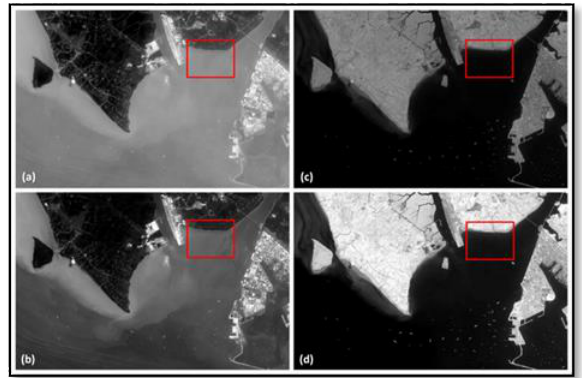
Figure 6. Landsat-8 multispectral satellite images of Tanjung Kupang, Strait of Johor area. Image (a) Blue (Band 2); (b) Green (Band 3); (c) Red (Band 4); and (d) NIR (Band 5). 3.3 Nautical Chart The measured bathymetric depths are obtained from the nautical chart MAL 5123 – Port of Tanjung Pelepas (scale 1 : 20,000). Image to map registration has been performed to precisely georeference the particular multispectral images into the designated geographical coordinate system. The resultant orthorectified image allows for the accurate direct measurement of positions, distances and areas.